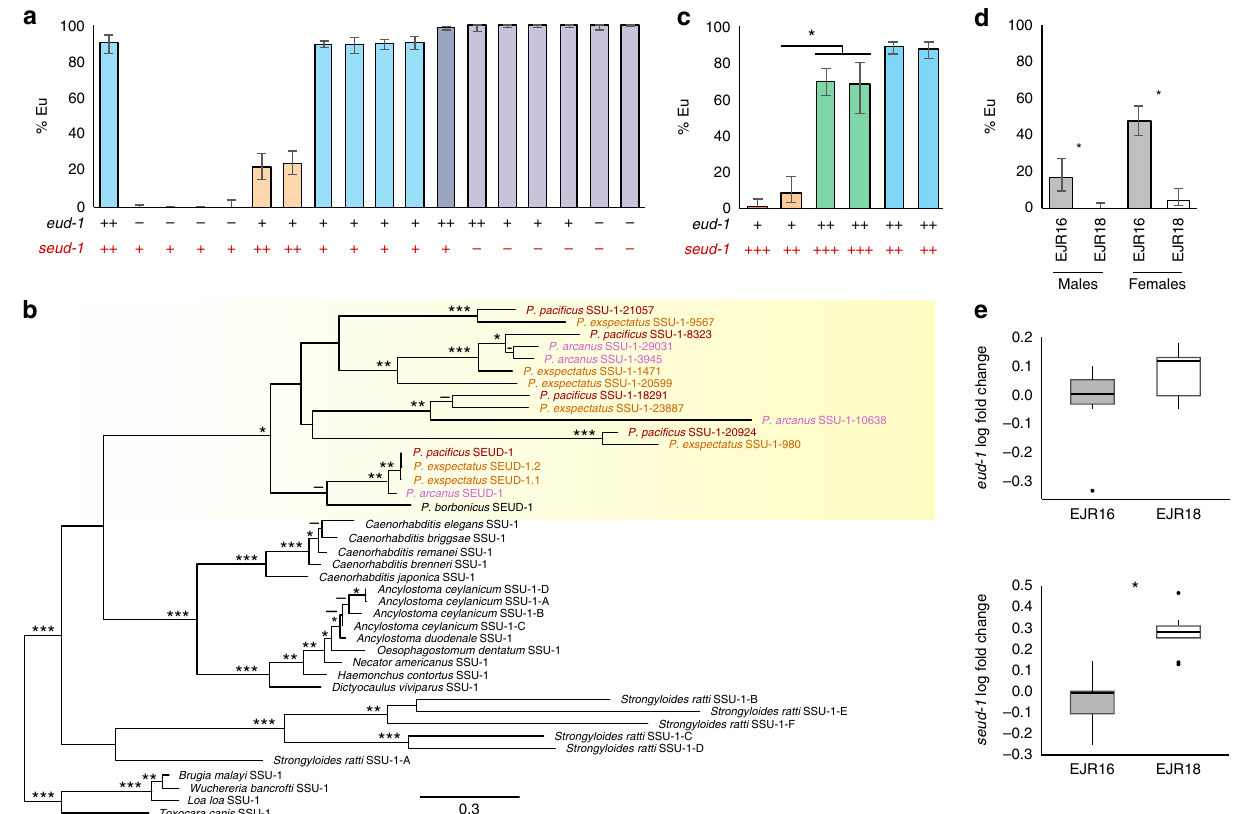
Fig. 4 Genomic dosage, duplication, macroevolution, and inbred divergence of seud-1 . a Compared to the wild-type (left bar), animals with the relative dosage of eud-1 to seud-1 manipulated (each dosage ratio marked by a unique bar colour) show a gradation of plasticity thresholds, as measured by the percentage of eurystomatous (Eu) individuals, produced in a common environment. Speci fi c crosses used to produce dosages of eud-1 to seud-1 , as indicated along the x -axis, are given in Supplementary Table 6. Each plus-sign below chart represents a functional (wild-type) gene copy present in cross offspring; each minus-sign, a non-functional (mutant) copy. b seud-1 (boldface font) is the product of gene duplications, particularly a large radiation of sulfotransferase-encoding ssu-1 homologues, speci fi c to a lineage including Pristionchus (yellow shading). Divergences even between three closely related species (marked in differently coloured fonts) indicates the dynamic divergence of these homologues, including the recent duplication of seud-1 in P. exspectatus . Amino-acid sequences were analysed by maximum likelihood. Bootstrap support values: ***99 – 100%; **96 – 98%; *75 – 95%; − 50 – 74%. c Manipulation of competing ( eud-1 : seud-1 , each dosage ratio marked by a unique bar colour) gene dosages using hybrids with P. exspectatus , support the function of both duplicates and their consequences on the different plasticity phenotype observed for P. exspectatus . Speci fi c crosses used to produce dosages of eud-1 to seud-1 , as indicated along the x -axis, are given in Supplementary Table 9. * P < 0.0001 ( χ 2 -test). d Lines of P. exspectatus (EJR16, EJR18) were systematically inbred from a heterozygous parent strain to result in different polyphenism ratios. * P < 10 − 4 ( χ 2 -test). e Inbred lines of P. exspectatus diverged in transcriptional dosage (log 2 fold change of expression) of seud-1 (i.e., Pex-seud-1.1 + Pex-seud-1.2 ), in particular relative to eud-1 , expression of which did not change ( P > 0.05). Box plots show ΔΔ Ct values (centre line, median; box limits, upper and lower quartiles; whiskers, 1.5× interquartile range; points, outliers). * P < 0.001 (Tukey ’ s test). Whiskers represent a 95% con fi dence interval showed no difference in either phenotype or seud-1 expression. Table 1 Environmentally induced expression changes in Further, eud-1 transcript levels were lower on a diet of C. albicus , seud-1 and only slightly lower in C. curvatus , further shifting the ratio of eud-1 to seud-1 transcripts on the former diet. Our results thus indicate that, in a single genetic background, different morph- inducing environmental cues result in relative transcriptional dosage of opposing factors making up the polyphenism switch.